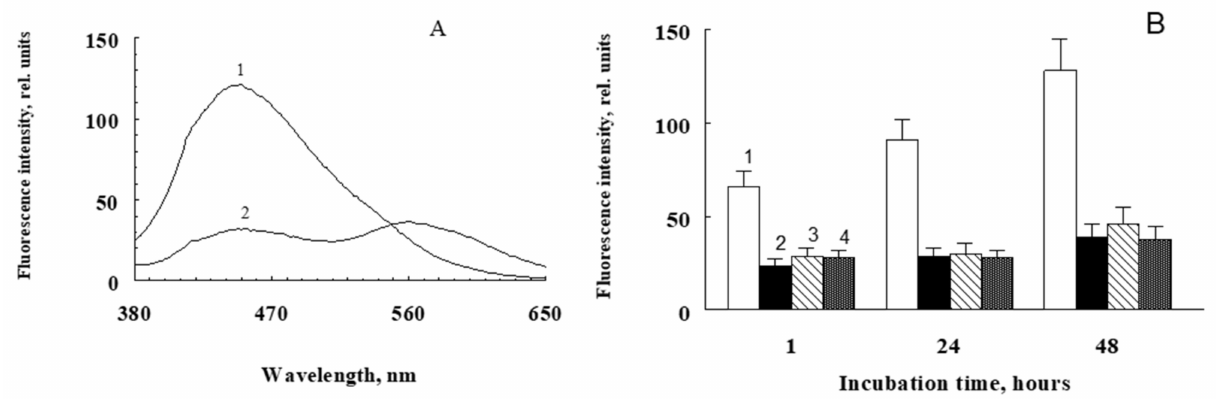
Figure 6. Modification of BSA upon irradiation of its complex with A2E. ( A ) Change in the fluores- cence spectrum of irradiated (1) and non-irradiated (2) BSA-A2E complex after 48 h of incubation at 37 ◦ C in the dark. ( B ) Kinetics of BSA fluorescence increase upon irradiation in the presence of A2E. Incubation medium: 0.1 M sterile K-phosphate buffer, pH 7.4, 2 mg/mL BSA, and 60 µ M A2E (columns 1 and 2). The samples were irradiated with an LED source for 1 h at room temperature, after which 3 mM sodium azide was added to all samples and incubated in the dark at 37 ◦ C. 1—BSA and A2E irradiated; 2—BSA and A2E dark; 3—irradiated BSA only; 4—dark BSA only. Data are means (means ± SD) of three assays; p <